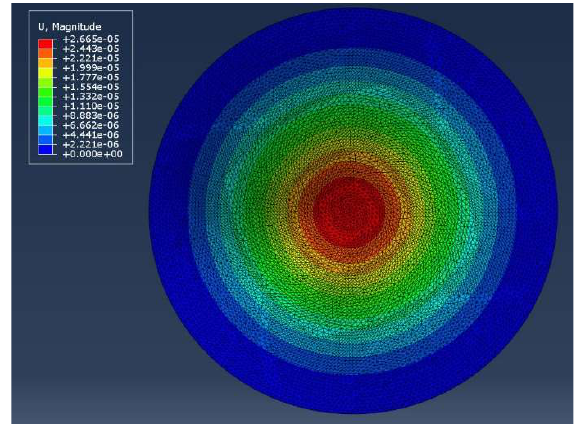
Figure 9. Cloud diagram of gravity mirror deformation. Table 1. The range of variation of the dimensional parameters of the reflector.